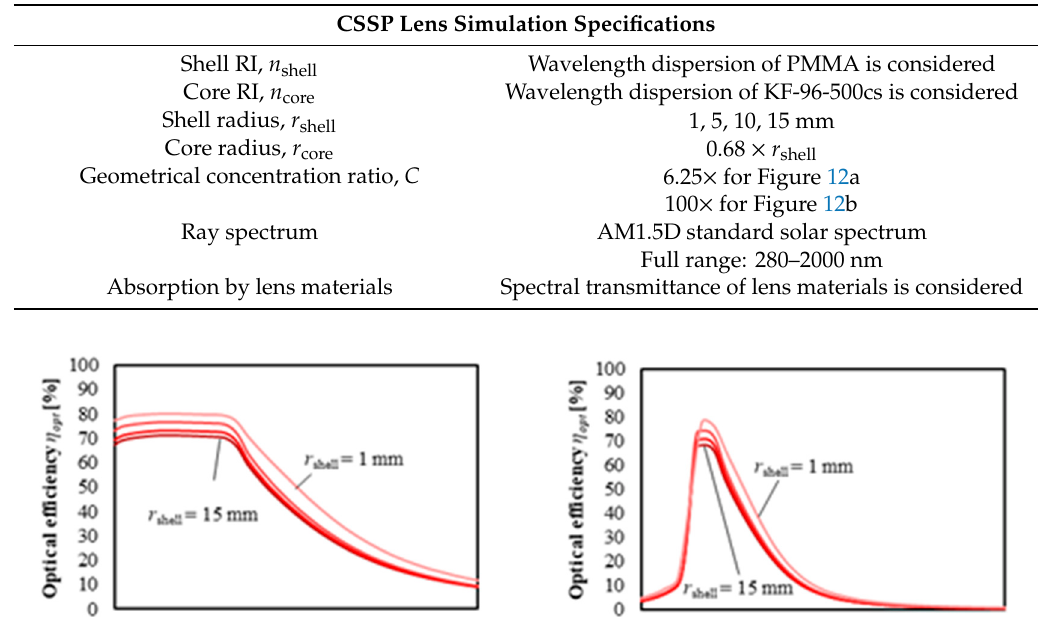
Table 6. Simulation conditions C. CSSP lens simulation specifications Shell RI, n shell